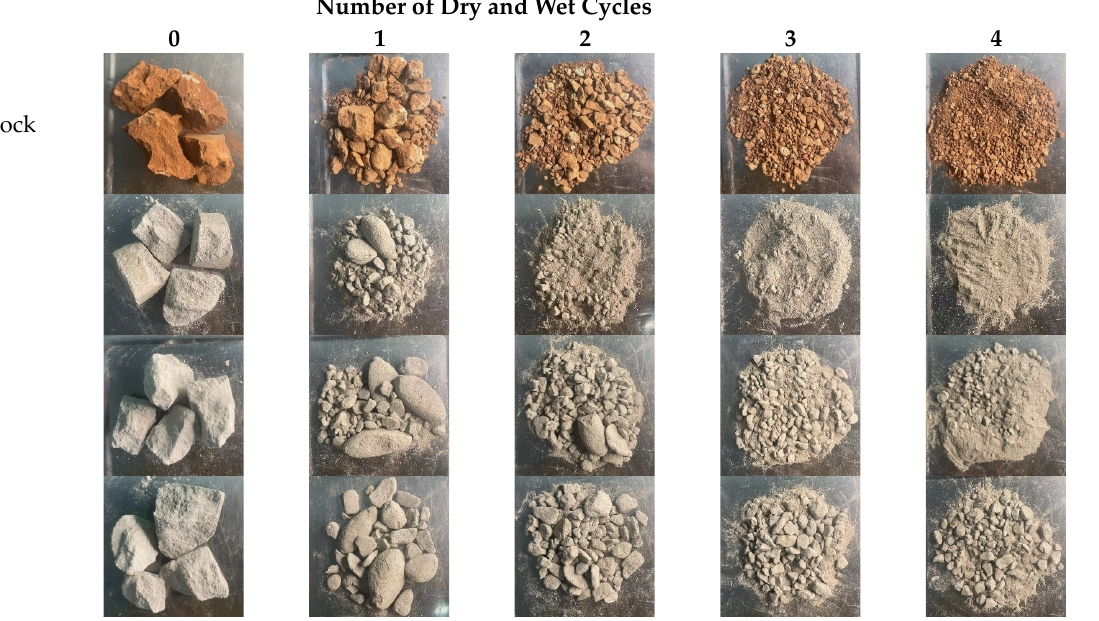
Figure 6. Disintegration resistance test performance of similar material specimens.